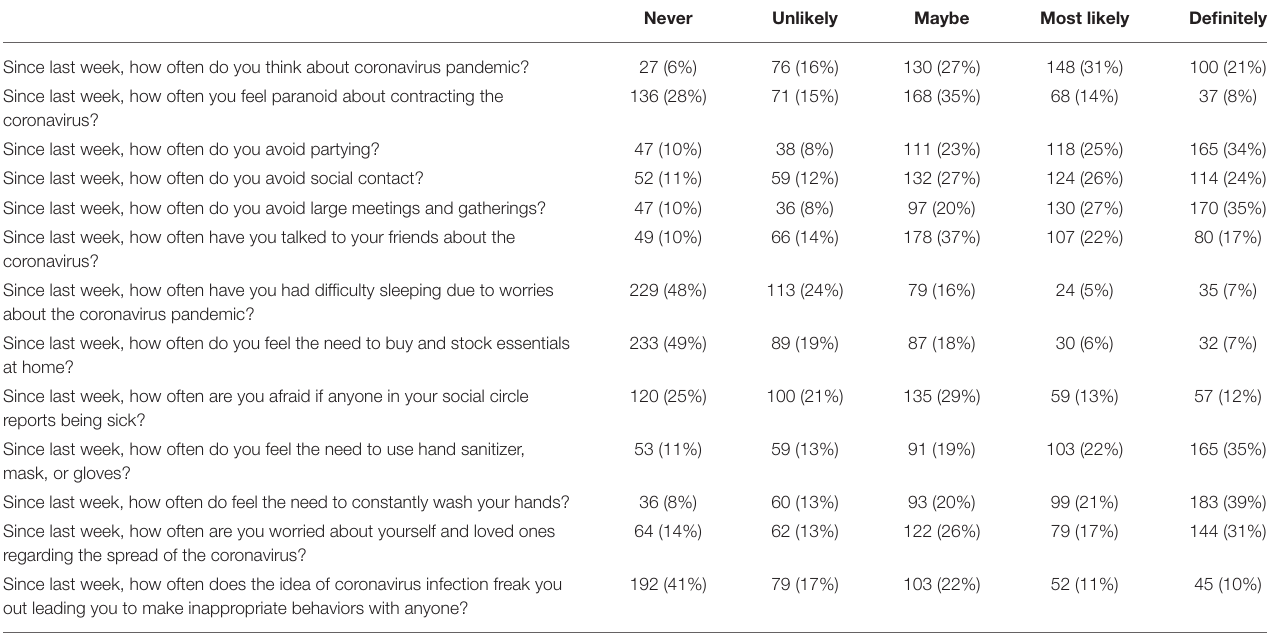
TABLE 6 | Anxiety associated with COVID-19 infection.